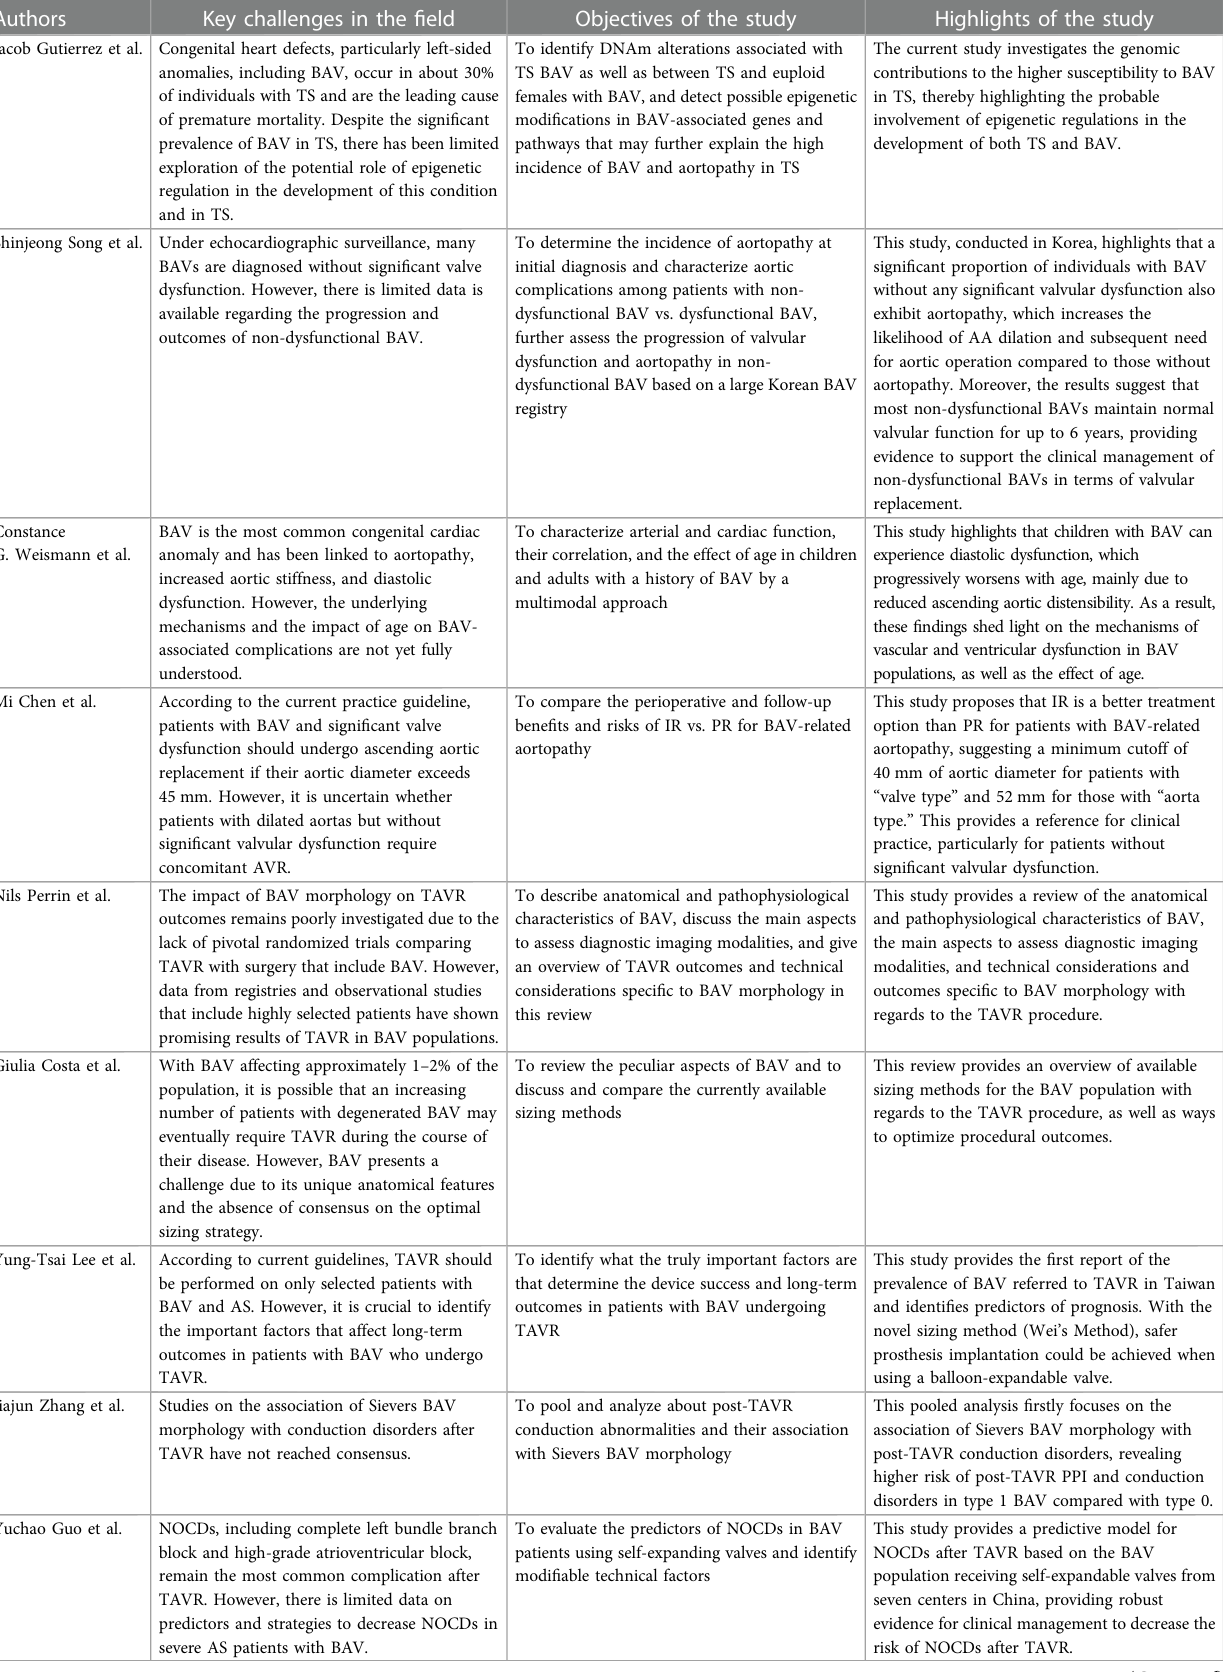
TABLE 1 Information and highlights of the 13 articles in the research